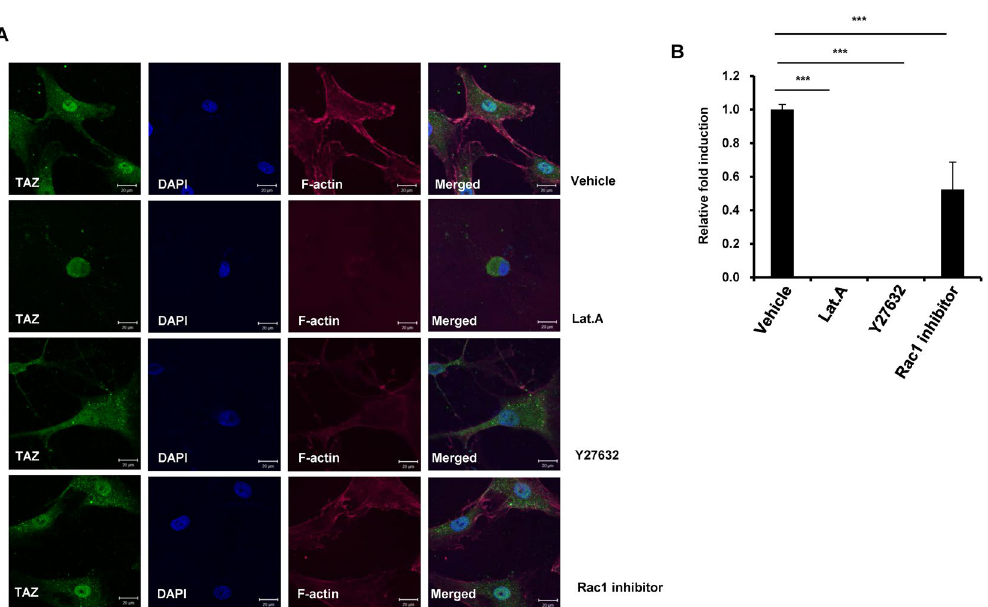
Figure 5. Inhibition of Rho/ROCK/F-actin represses TAZ nuclear localization and TAZ target-gene expression induced by nanopattern plates. ( A ) MSC were seeded on O70 nanopattern plates and 24 hr after seeding, latrunculin A, Y27632, and Rac1 inhibitors were added for 4 hr. Cells were stained with TAZ specific antibody and counterstained with phalloidin and DAPI for visualization of filamentous actin and nucleus, respectively. ( B ) Cells in panel ( A ) were harvested and total RNA was prepared. TAZ target gene CTGF was analyzed by qRT-PCR. n = 3, *** p < 0.005,